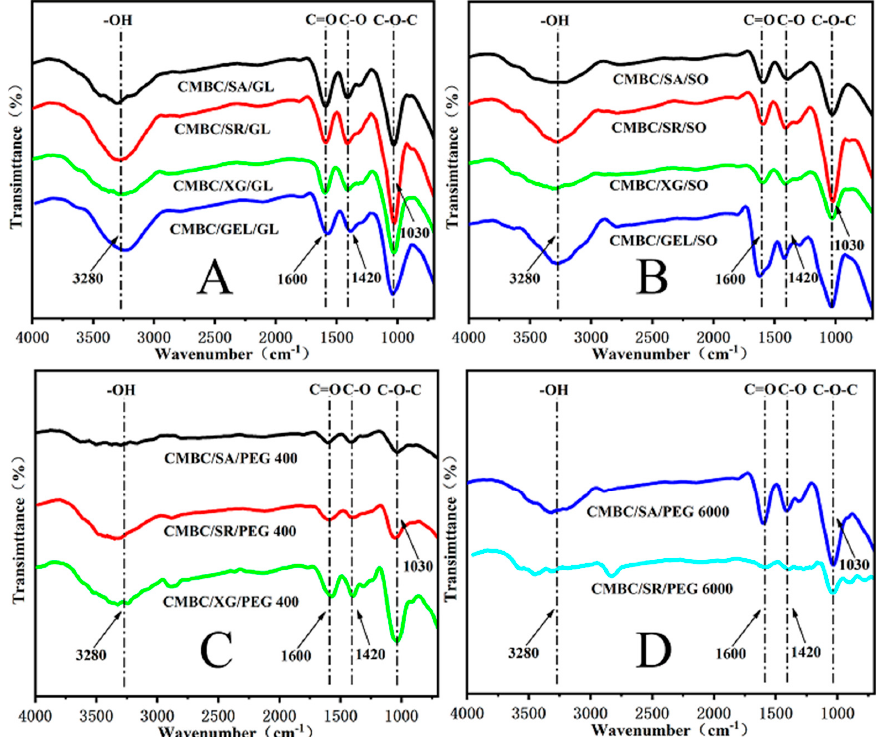
Figure 3. FTIR images of the composite films ( A ) : CMBC/SA/G, CMBC/SR/Gl, CMBC/XG/Gl & CMBC/GEL/Gl; ( B ) : CMBC/SA/SO, CMBC/SR/SO, CMBC/XG/SO & CMBC/GEL/SO; ( C ) : CMBC/SA/PEG 400, CMBC/SR/PEG 400 & CMBC/XG/PEG 400; ( D ) : CMBC/SA/PEG 6000 & CMBC/SR/PEG 6000).